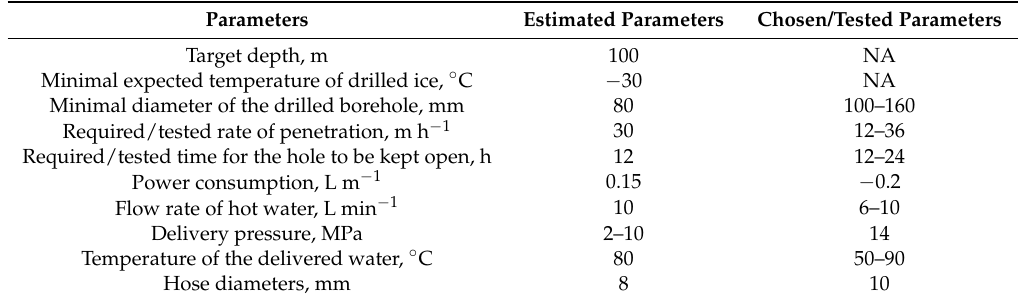
Table 1. Estimated and chosen/tested parameters of Jilin University (JLU) shallow, hot-water, ice-drilling system.